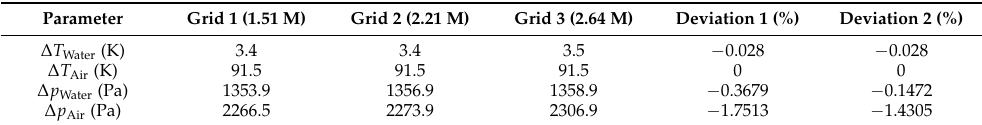
Table 2. Grid independent test.